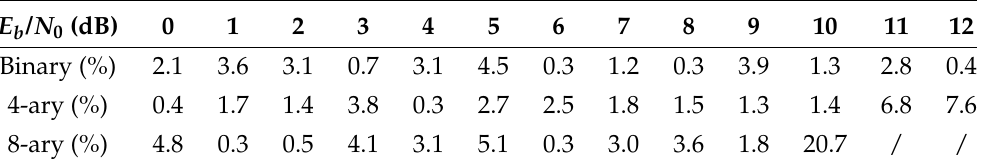
Table 1. The errors between the BER performance and the theoretical results of suboptimal receiver (100 × 10 3 PPM symbols).